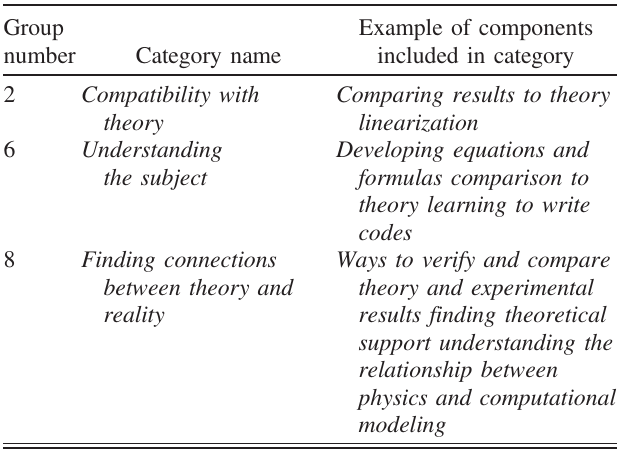
TABLE III. Student categories corresponding to the top-down category “ constructing a theoretical model ” and examples for components included in